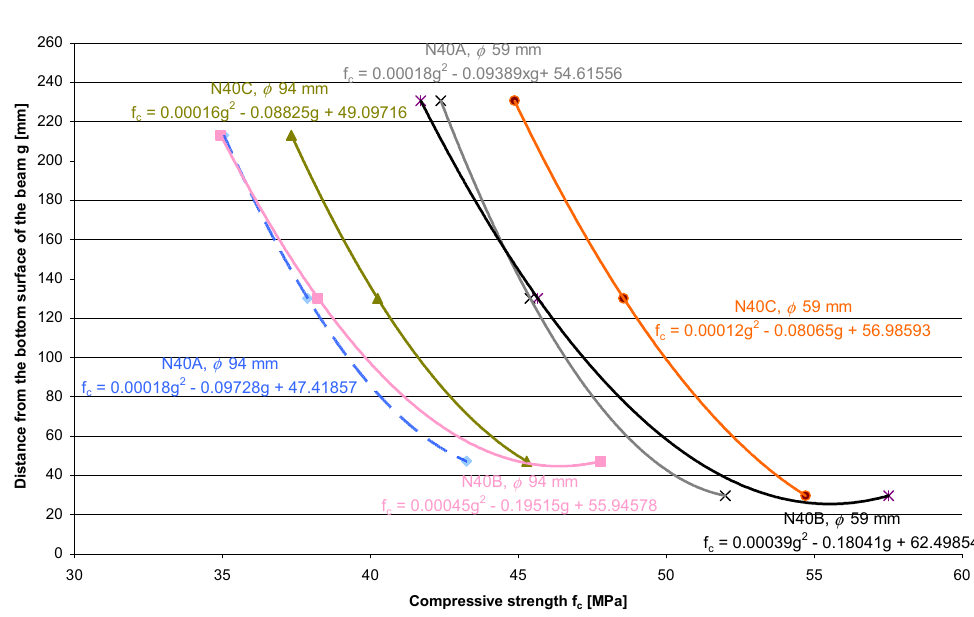
Figure 6. Distribution of the compressive strength of the 40 MPa concrete, which was determined across the height of the core samples with diameters of 59 mm and 94 mm.